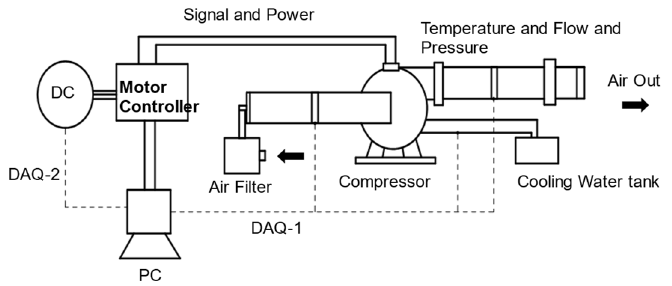
Figure 5. Test bench for air compressor.